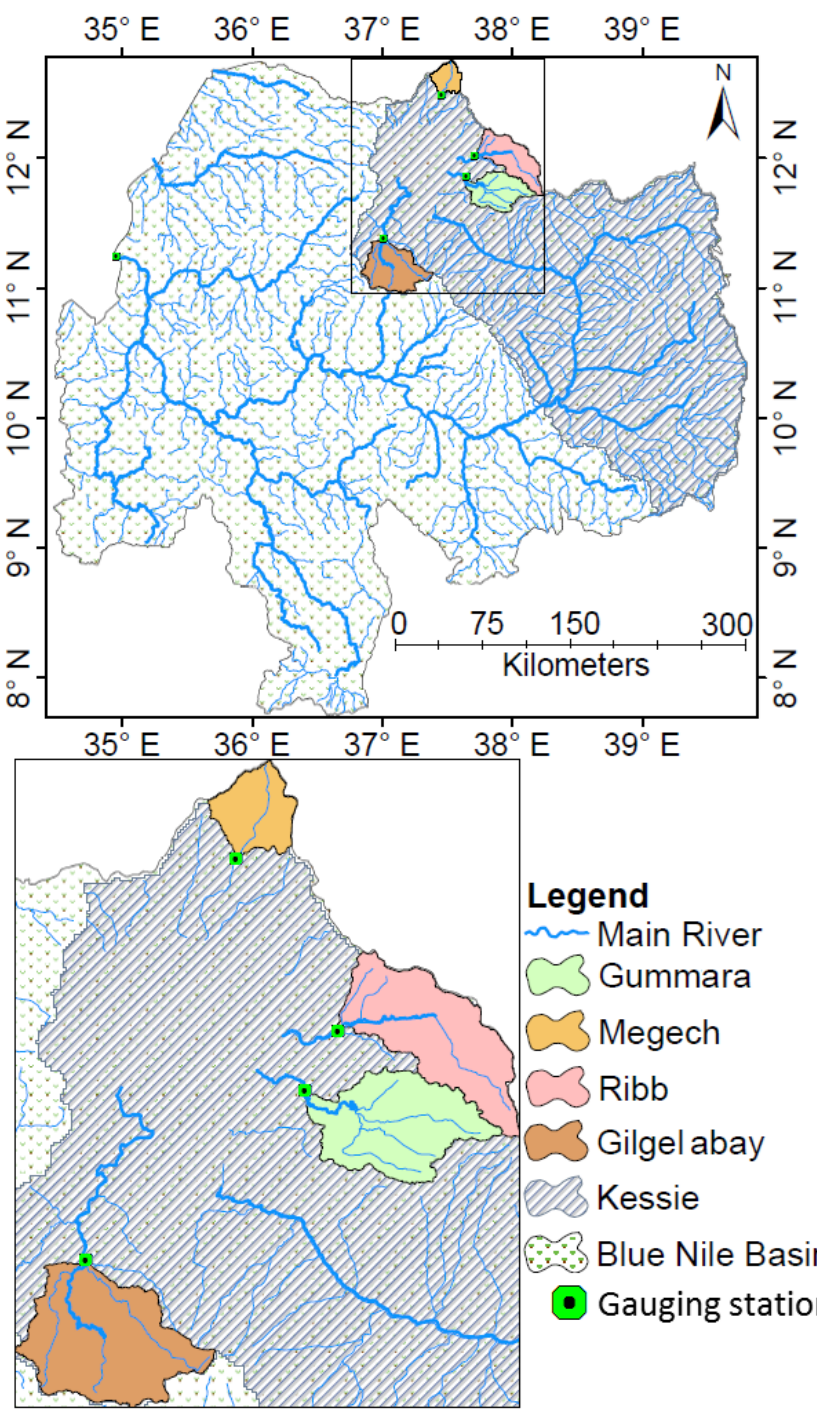
Figure 1. Location map of the study area (top). The bottom map shows the small-scale basins with high resolution. Six streamflow gauging stations, namely, Gilgel Abay, Gummara, Ribb, Megech, Kessie and Eldiem, were considered in this study to investigate the robust probability distribution function.